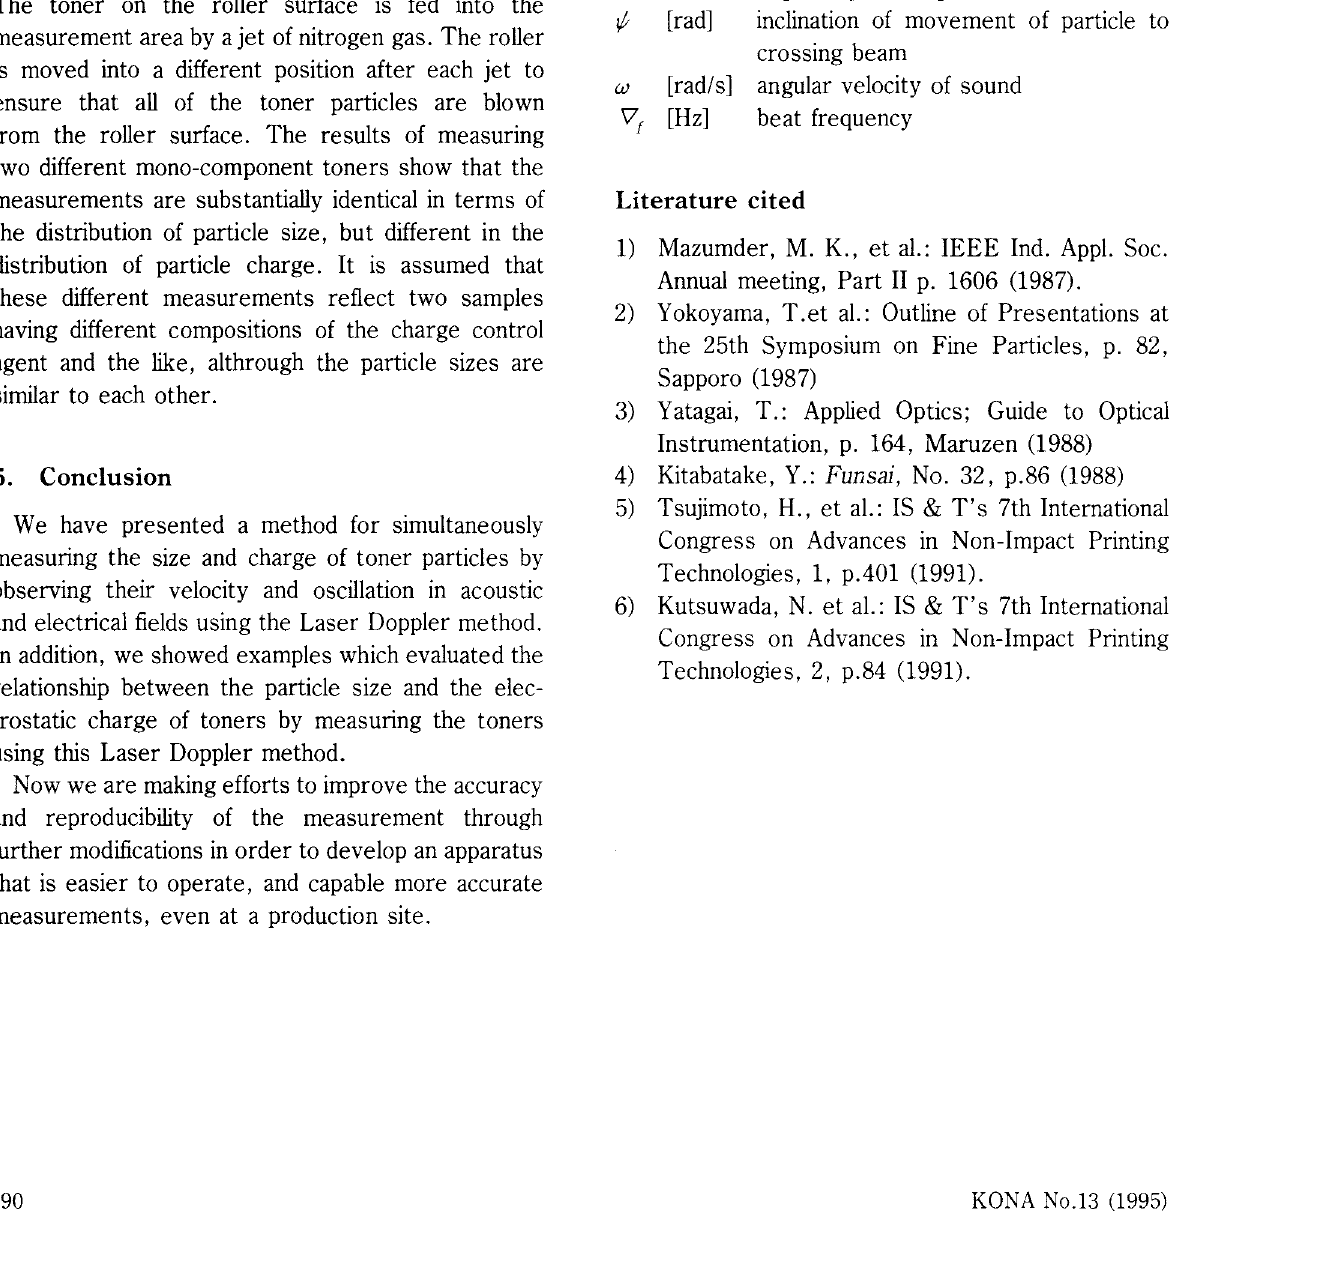
Fig. 10 Feeding device of charged single-component toner the feeding device, a developing roller with a mono component toner affixed to it (i.e.-after the toner has been charged) is removed from the copying machines and set directly onto the feeding